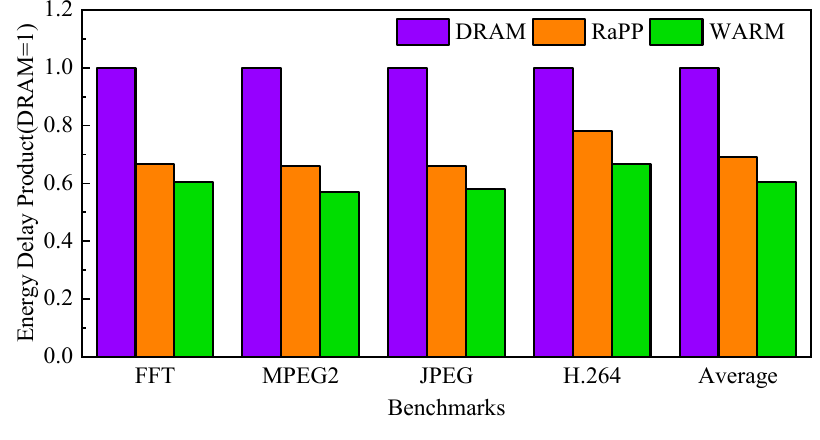
Figure 10. Energy delay product.